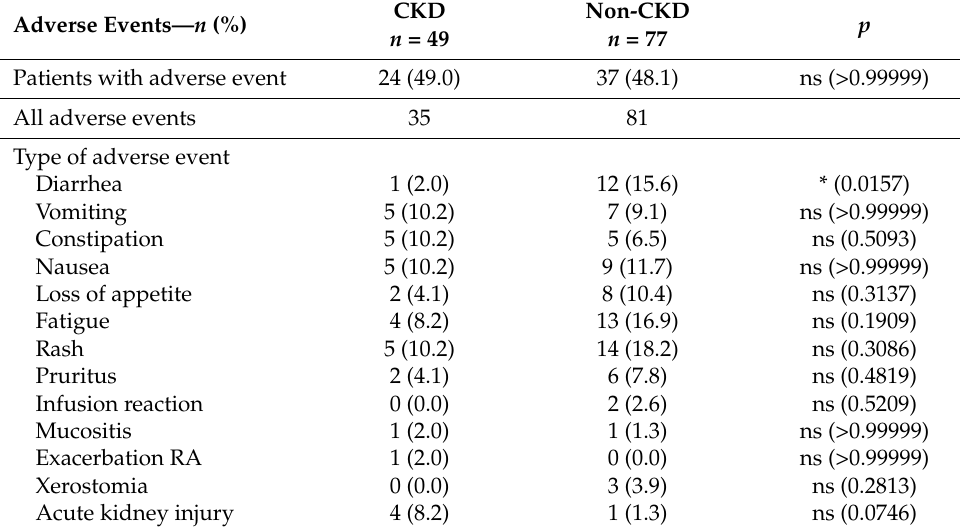
Table 4. Adverse events (AE) during checkpoint inhibitor therapy. RA = rheumatoid arthritis. CKD = chronic kidney disease; ns = not significant; * =